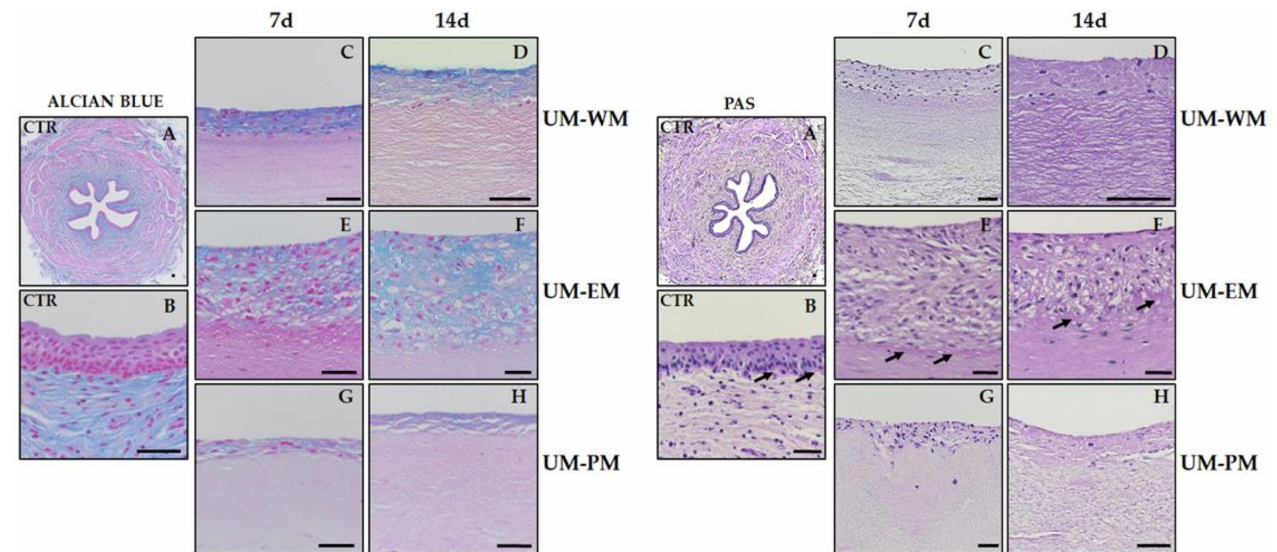
Figure 4. Alcian blue and PAS histochemical analysis of control human UM (CTR) and tubularized heterotypical sub-stitutes of the human UM cultured with three different media (WM, EM, and PM) for 7 and 14 days. Illustrative areas showing positive signal are highlighted with black arrows in the PAS panel. Scale bars: 500 µ m in ( A ) and 50 µ m in ( B – H